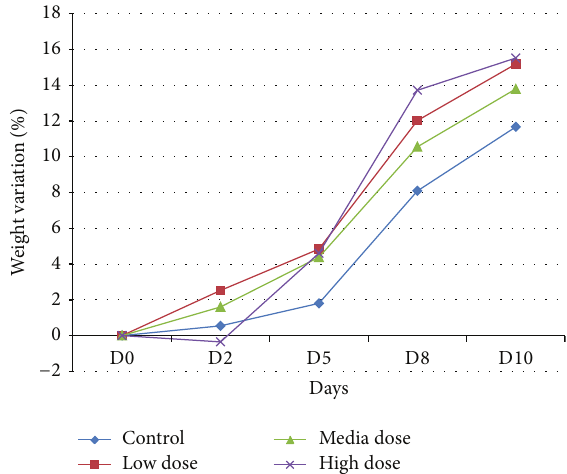
Figure 11: % of weight variation in subacute assay treated mice; the 𝑋 -axes show the days after treatment (D: day) while the 𝑌 -axes show the percentage of weight variation after treatment compared to the initial weight. Everyday weight variation is compared on the weight of the first day of treatment. The error bars in the graph are below 1% and are thus not